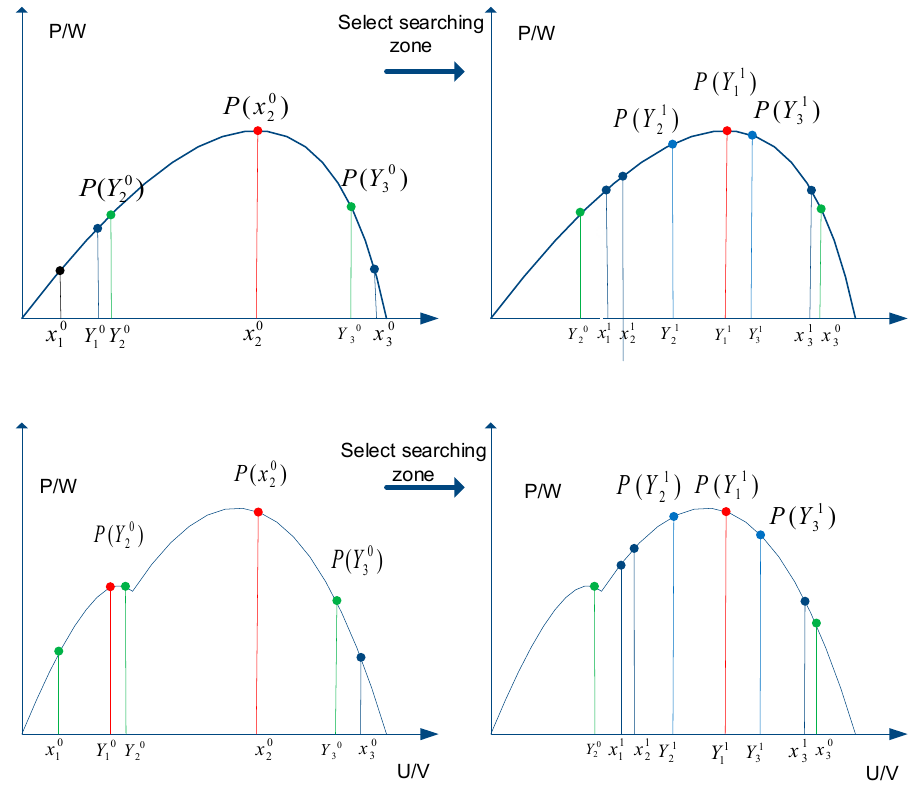
Figure 25. Dual chaotic search method [99].